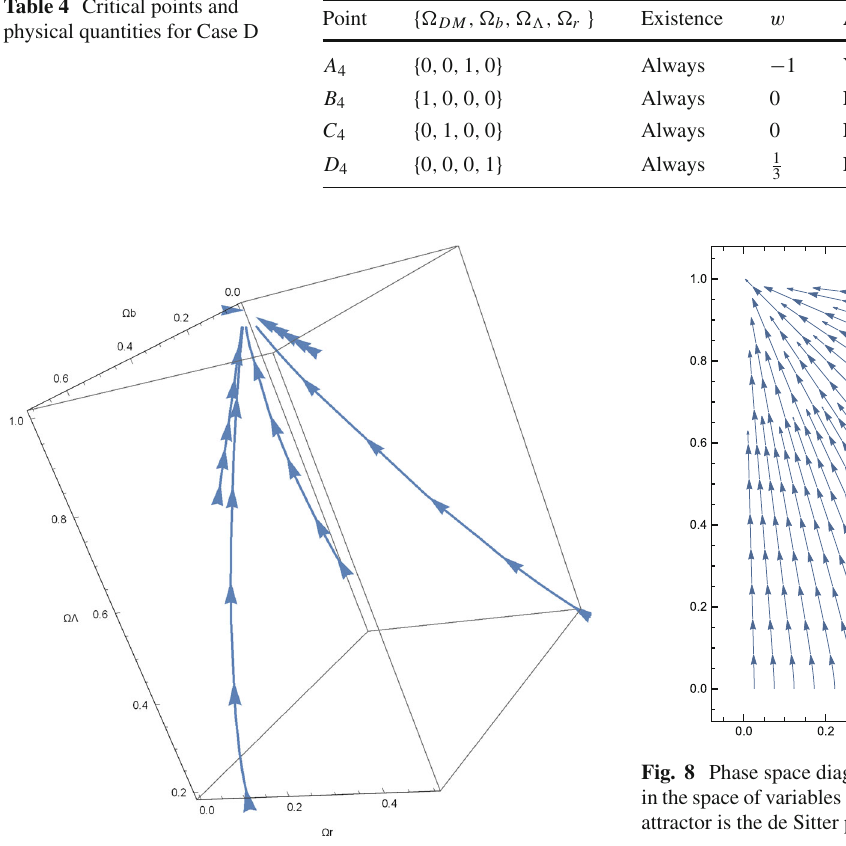
Table 4 Critical points and